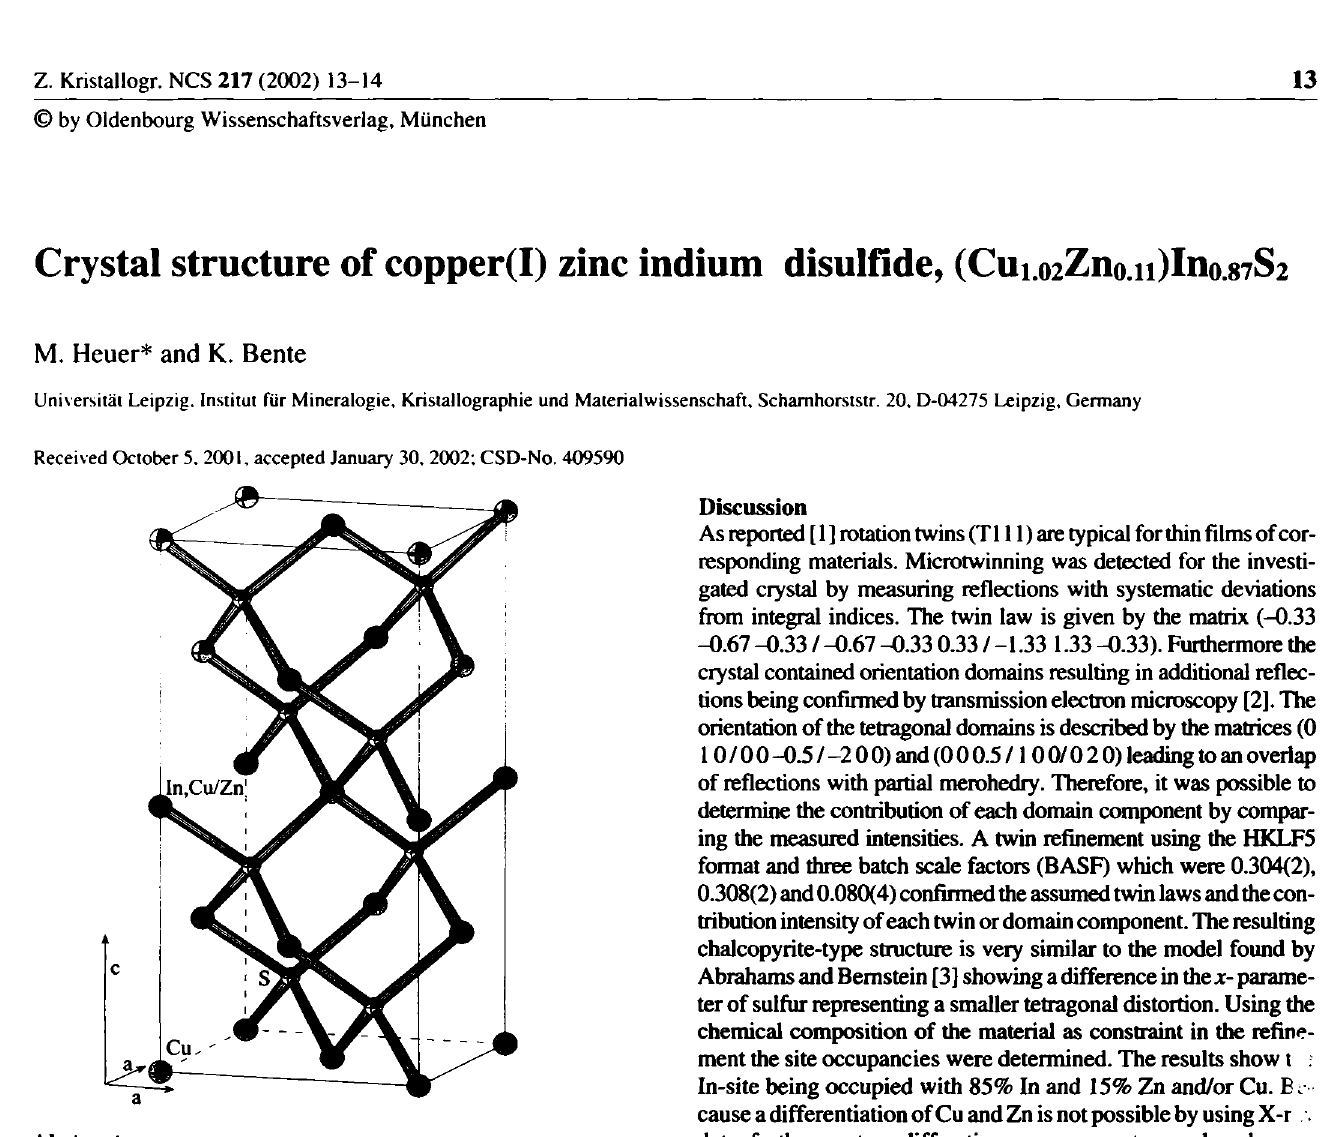
Table 1. Data collection and handling. Crystal: